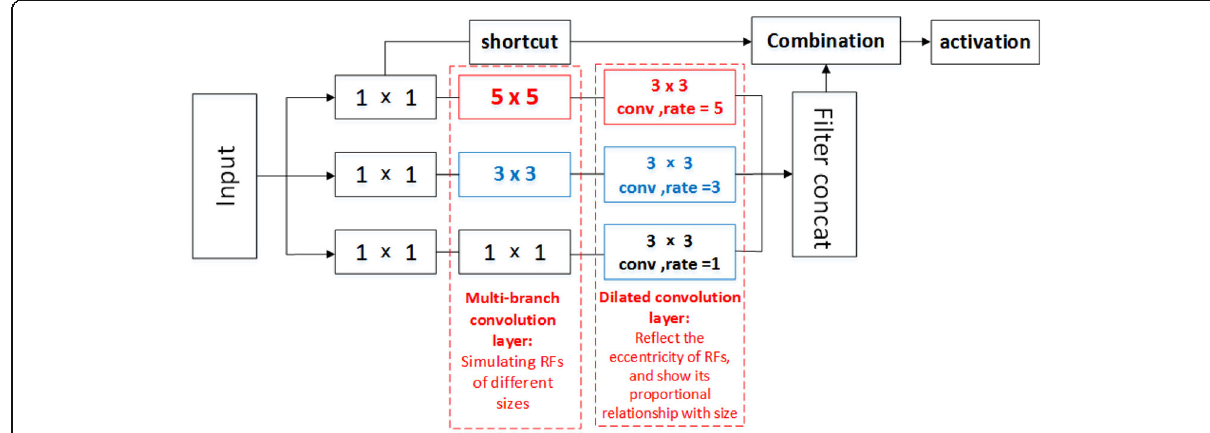
Fig. 5 The structure diagram of the RFB module. Similar to Fig. 3a, the Dilated convolution layer is added on the basis of multi-branch convolution to simulate the proportional relationship between the size and the centrifugal rate of the RFs in the human retina